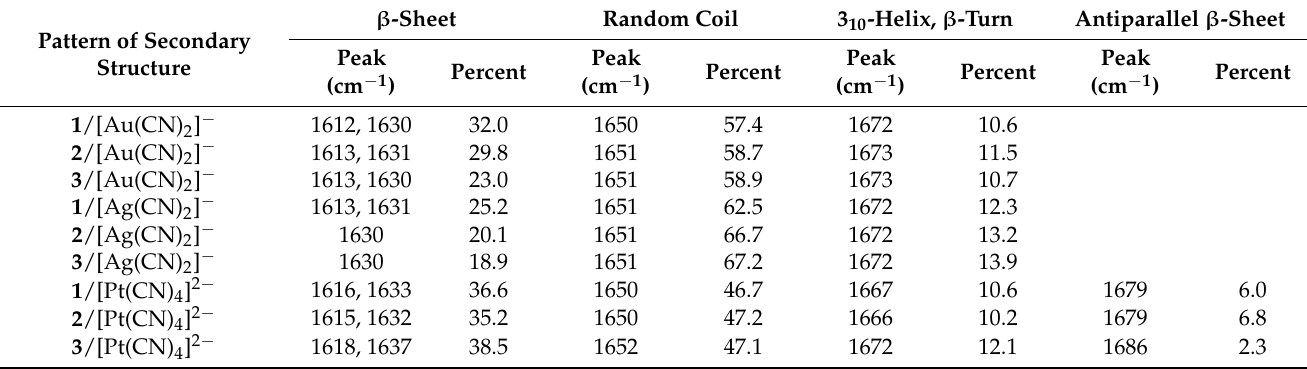
Table 3. Data obtained from amide peaks in FTIR spectra indicating the percentage contributions of β -sheet (1610–1640 cm − 1 ), random coil (1640–1660 cm − 1 , including P II structures), 3 10 -helix or β -turn-like (1660–1685 cm − 1 ), and antiparallel β -sheet (1675–1690 cm − 1 ) secondary structures [72–76] for hybrid 1 – 3 /cyanometallate